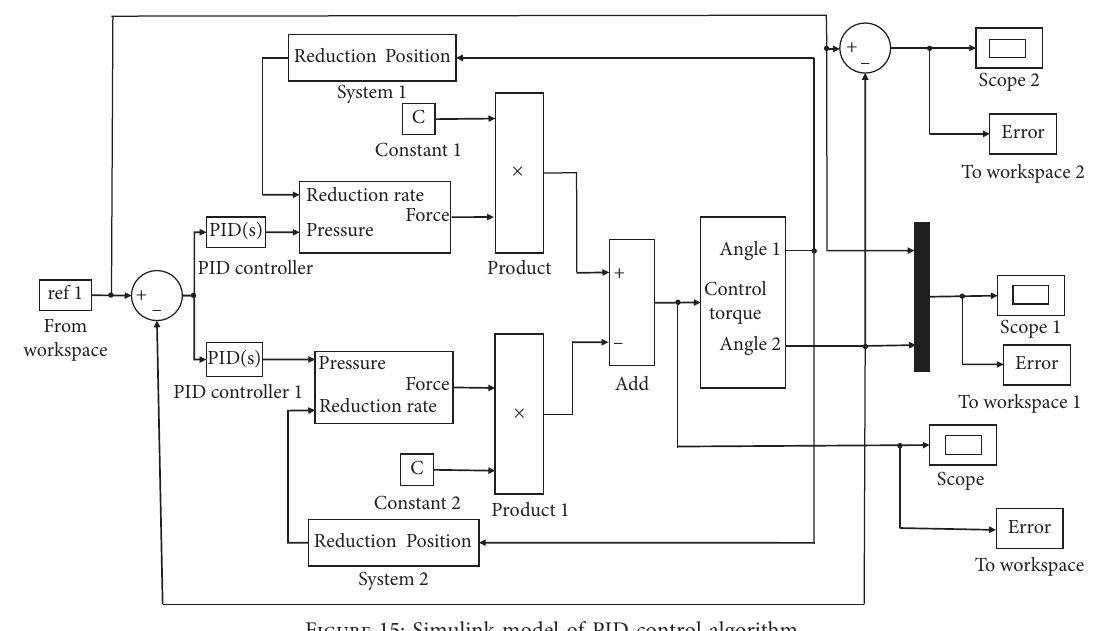
Figure 15: Simulink model of PID control algorithm.